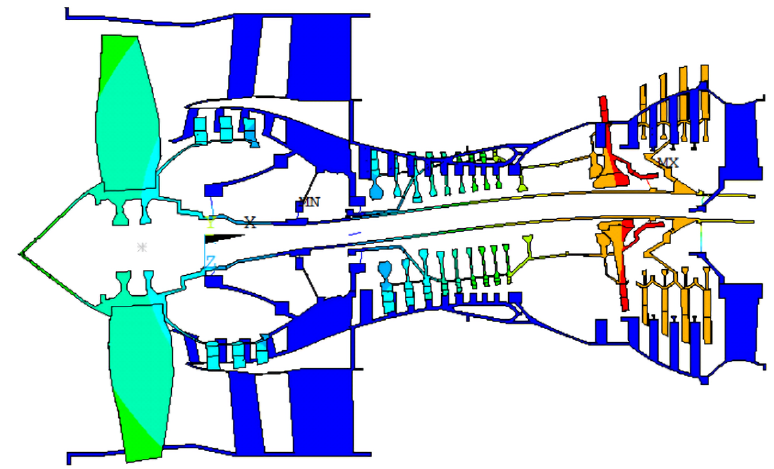
Figure 9. The first critical speed modal shape.